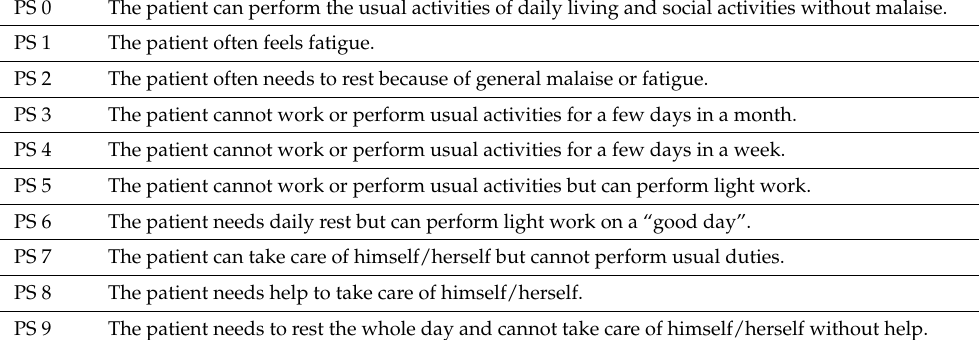
Table 1. Performance status scoring